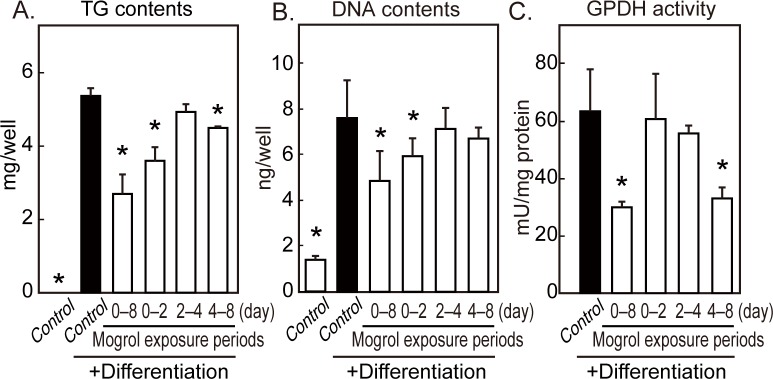
Effects of mogrol during the different stages of 3T3-L1 differentiation.3T3-L1 cells were differentiated for 8 days and 20 μM mogrol was only added at the indicated stages of cell differentiation. The amounts of (A) triglyceride (TG), (B) DNA, and (C) glycerol-phosphate dehydrogenase (GPDH) activity were determined. Data represent the mean ± SD of a representative result of three independent experiments. Error bars indicate the SD of three (A, C) or six (B) replicates. *p < 0.05 for the comparison with cells differentiated in the absence of mogrol (solid black bar), one way ANOVA with Dunnett’s post-hoc test.